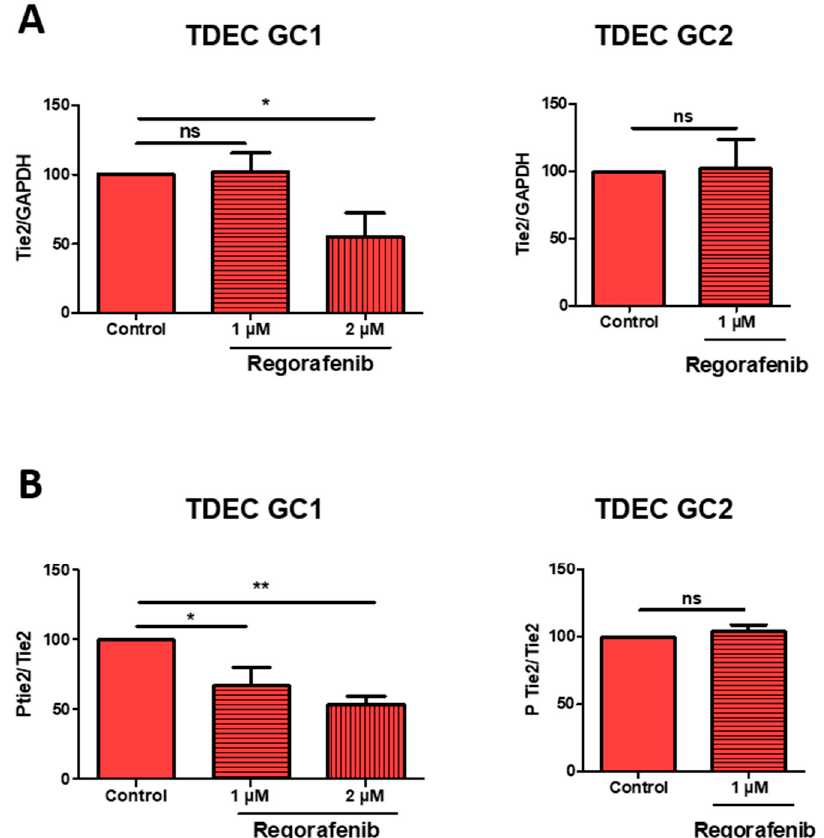
Figure 5. High-dose regorafenib decreases Tie expression and phosphorylation in TDEC IR+. ( A ) Immunoblot of Tie2 in TDEC IR+ GC1 and TDEC IR+ GC2 with or without 1 or 2 µM of regorafenib. Blots were quantified and the graphs show the protein expression ratio normalised to TDEC IR+ obtained from each GSC without regorafenib (control). ( B ) Ptie2/Tie expression ratio evaluated by immunoblot. The graphs show the protein expression ratio normalised to TDEC IR+ obtained from each GSC without regorafenib (control) ; * p < 0.05; ** p < 0.01.